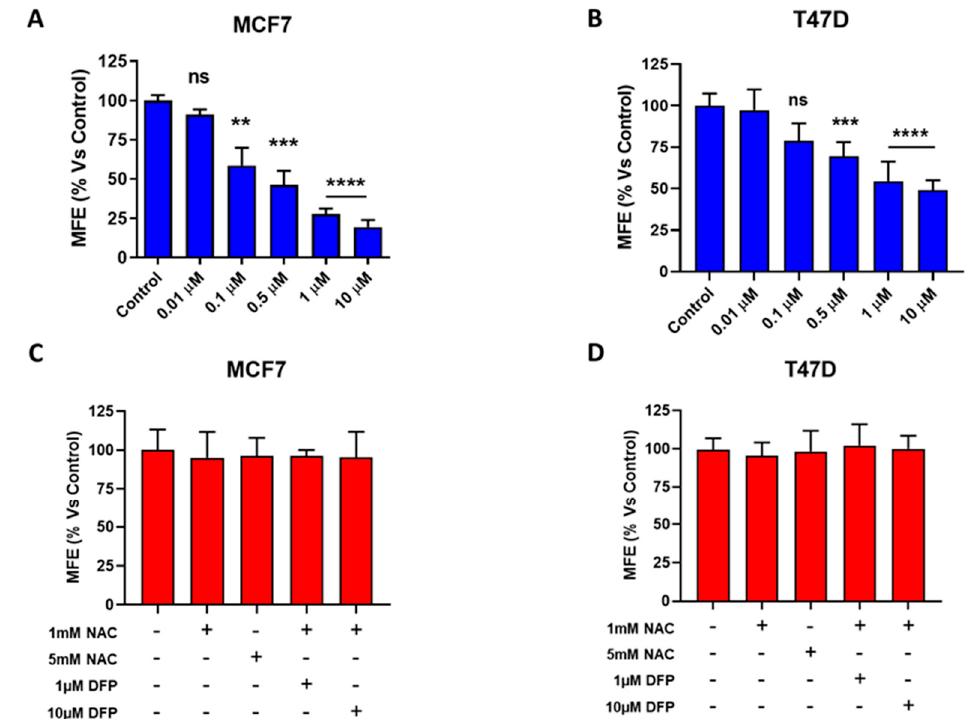
Figure 2. DFP inhibits cancer stem cell (CSC) propagation in MCF7 and T47D cells. We used